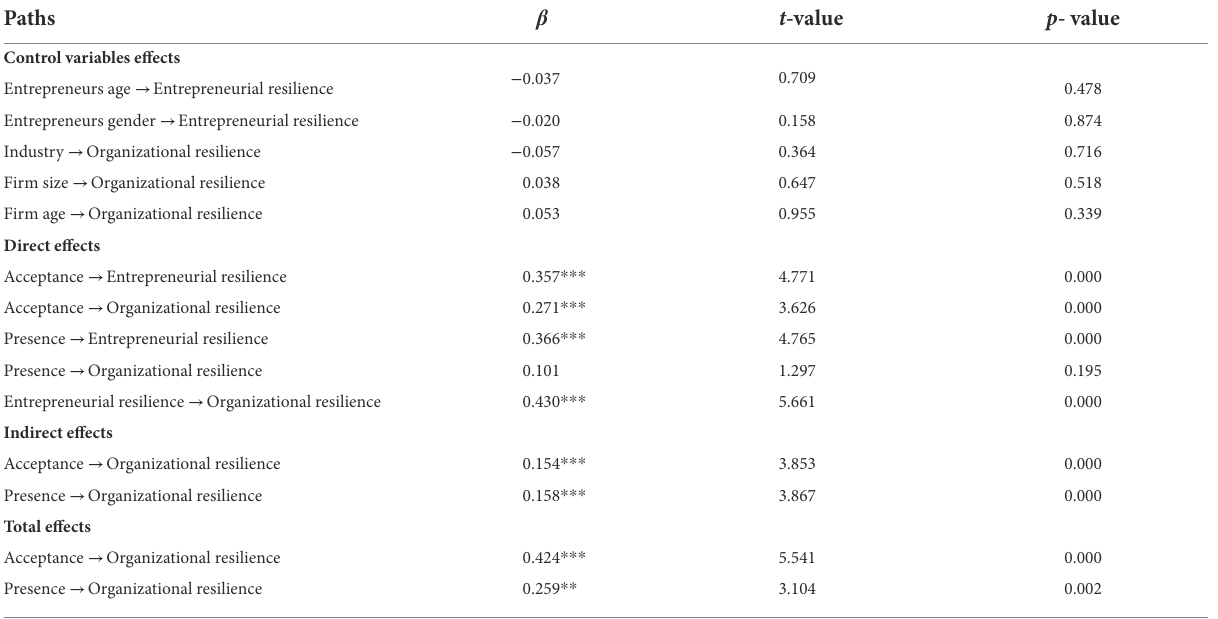
TABLE 11 First-order constructs and organizational resilience.